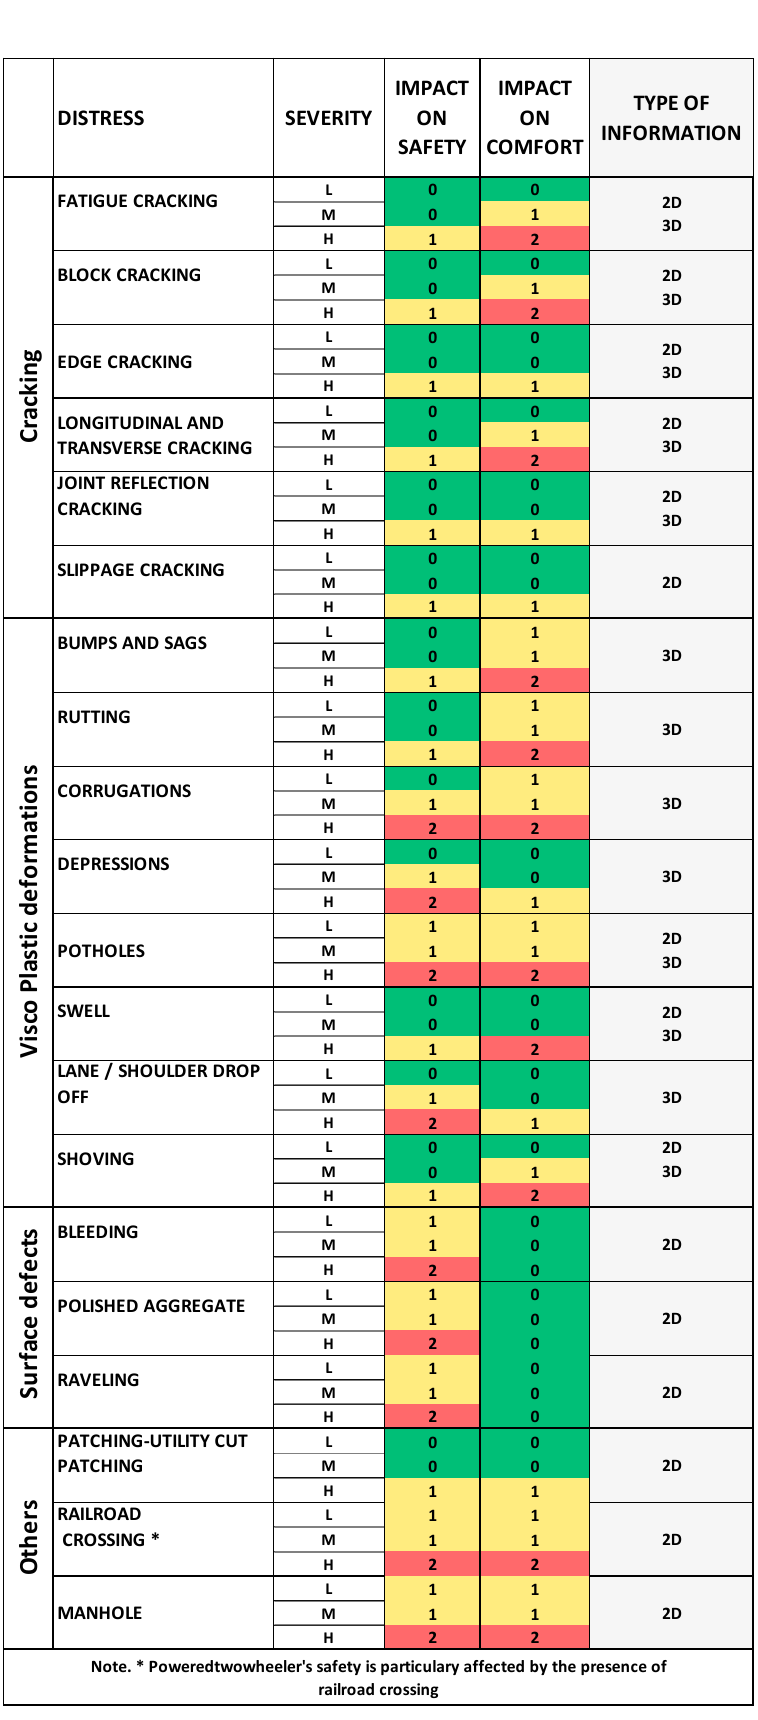
Figure 1. Distress classification according to safety and comfort criteria